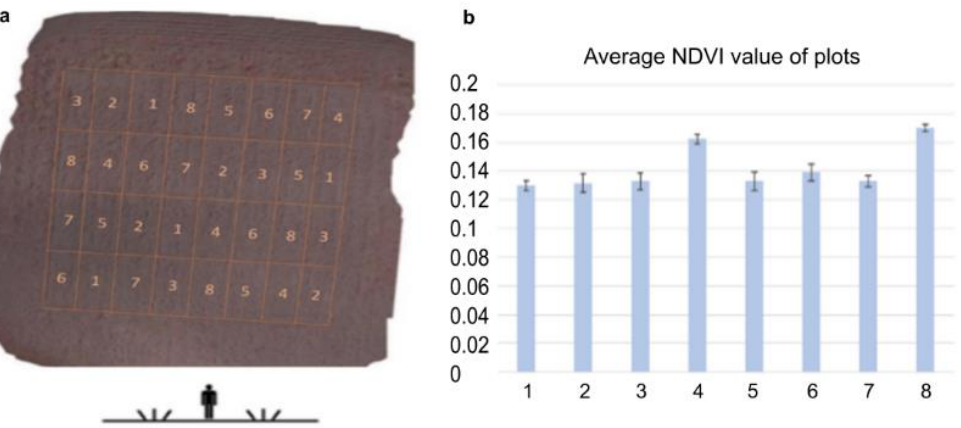
Figure 2. Changes of crop yield after treatments of 10–240 g ha − 1 dosage of ELICE16INDURES. The commercially available plant conditioner, Fitokondi (F) was used as a positive control (4 L ha − 1 ). ( a ) Determination of moisture calculating mean values of four parallel parcels (%), moisture values were not significant according to the F-probe. ( b ) Determination of crop yield at 8% moisture content, calculating the mean values of four parallel parcels (T ha − 1 ). According to the F-test, these values were significant at the P10%. ( c ) Determination of mean values of crop measured in four parallel parcels in kg plots − 1 ; to better understand, the yield enhancement is represented in percent increase in the diagram. According to the F-test, these values were significant at the P10%. A significant increase in yield was detected in the two investigated dosages of 20 and 240 g ha − 1 .